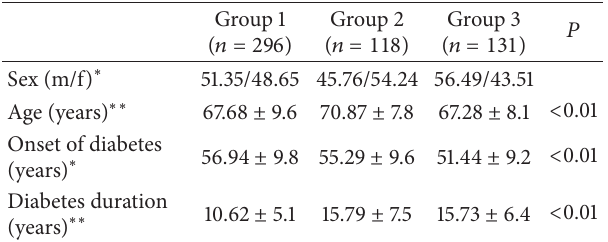
Table 1: Basic characteristics of type 2 diabetic patients ( 𝑛 = 545 ) divided into three groups according to diabetic retinopathy status.